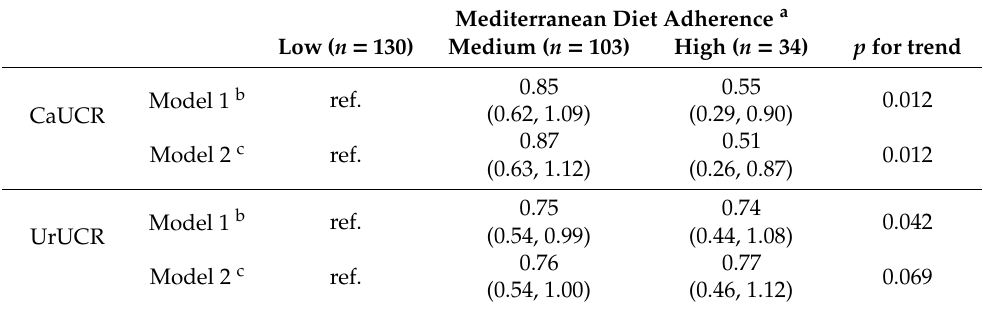
Table 3. Prevalence ratios (95% CIs) for high CaUCR and high UrUCR in groups that had low, medium, and high adherence to the MedDiet. .